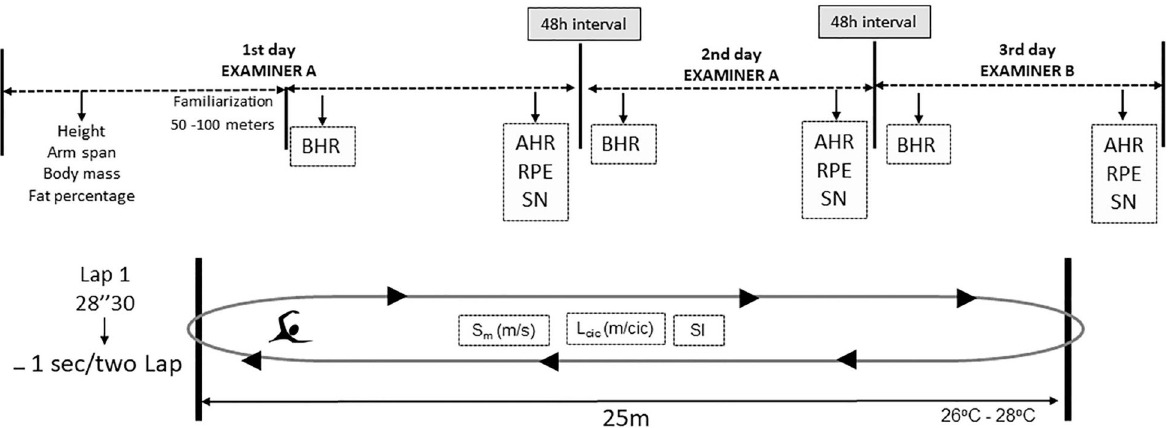
Figure 1 - Schematic illustration of study design. BHR - before (test) heart rate in beats per minute; AHR - after (test) heart rate in beats per minute; SN - swimming number (laps); S m - Average speed in meters per second (average number of laps performed); L cic - stroke cycles length in meters per cycle (average number of laps performed); SI - stroke